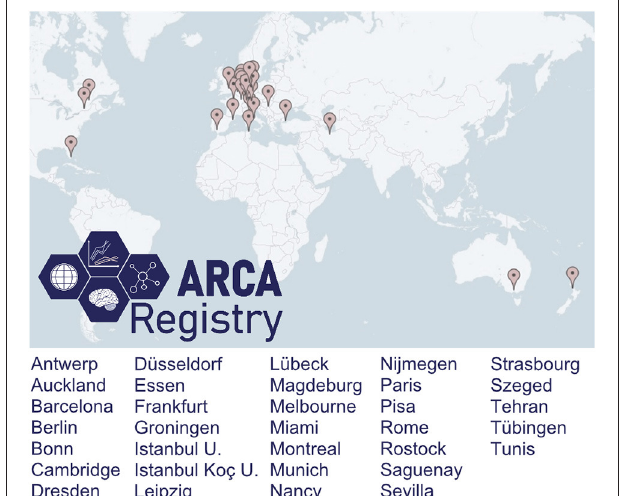
FIGURE 2 | Contributing centers. The ARCA Registry is a growing, cross-continental multicenter registry, with more than 30 contributing sites in 15 countries by the end of